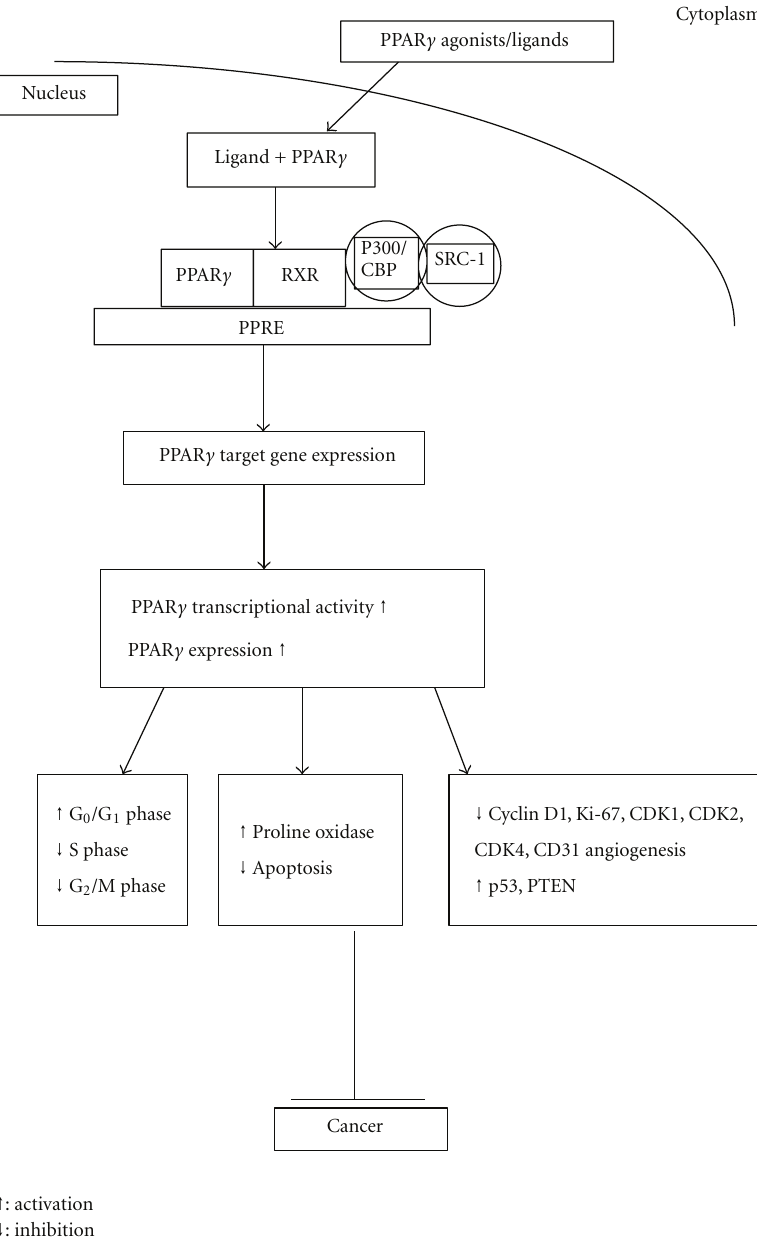
Figure 1: PPAR γ activity. Upon ligand binding PPAR γ , binds to RXR in the nucleus and associates with coactivators to bind PPRE located on target genes that control various